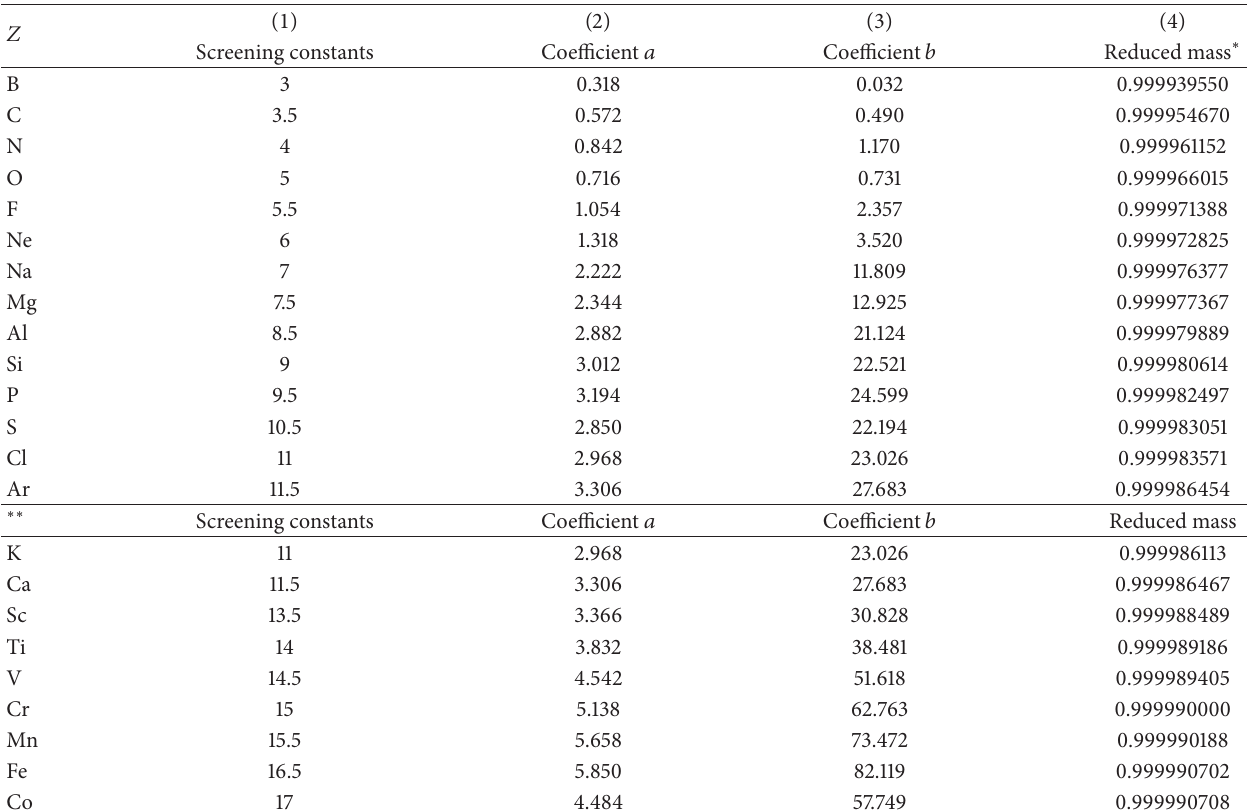
Table 2: Coefficients/constants for calculating ionization energies of multielectron